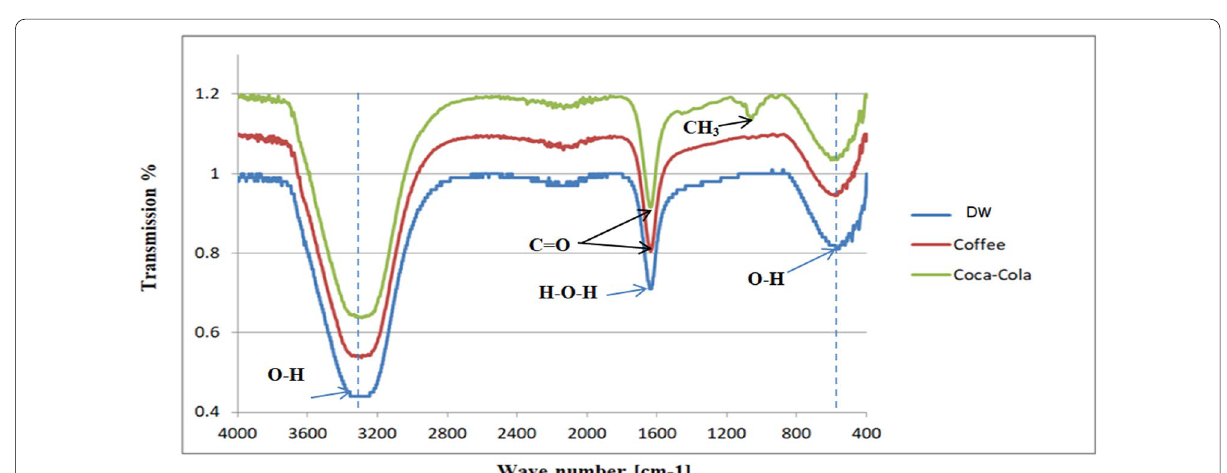
Fig. 4 FTIR spectra representing the chemical structure of DW, Coffee and